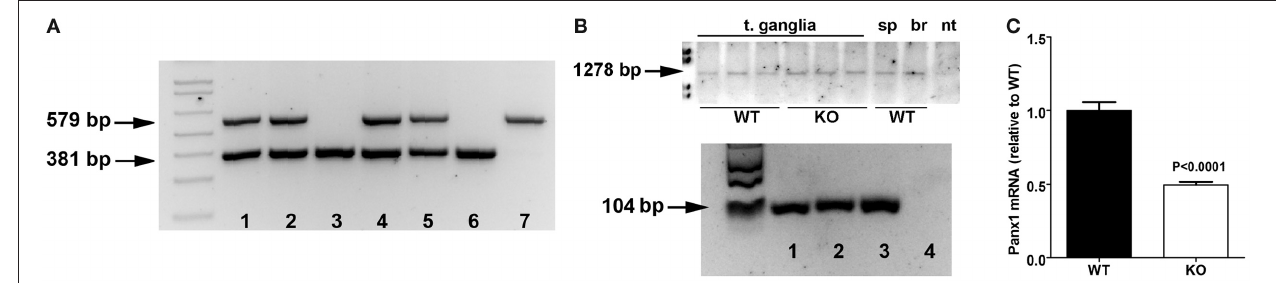
FIGURE 2 | Panx1 KO-first mice express Panx1 mRNA. (A) Tail PCR products obtained using specific primers (primer sets F1a—R1a and F1b—R1b depicted in Figure 1 ) designed to detect wild-type (579bp amplicon; lane 7), homozygousPanx1 KO-first (381bp amplicon; lanes 3 and 6) and the heterozygous(579 and 381bp amplicons; lanes 1, 2, 4, and 5) alleles. Data are from a litter derived from heterozygousbreeding. (B) Top : RT-PCR products obtained from tissues of wild-type (WT) and Panx1 KO-first (KO) using primers (primer set F2—R2 depicted in Figure 1 ) designed to detect wild-type Panx1 mRNA (1278bp) coding region. T. ganglia, trigeminal